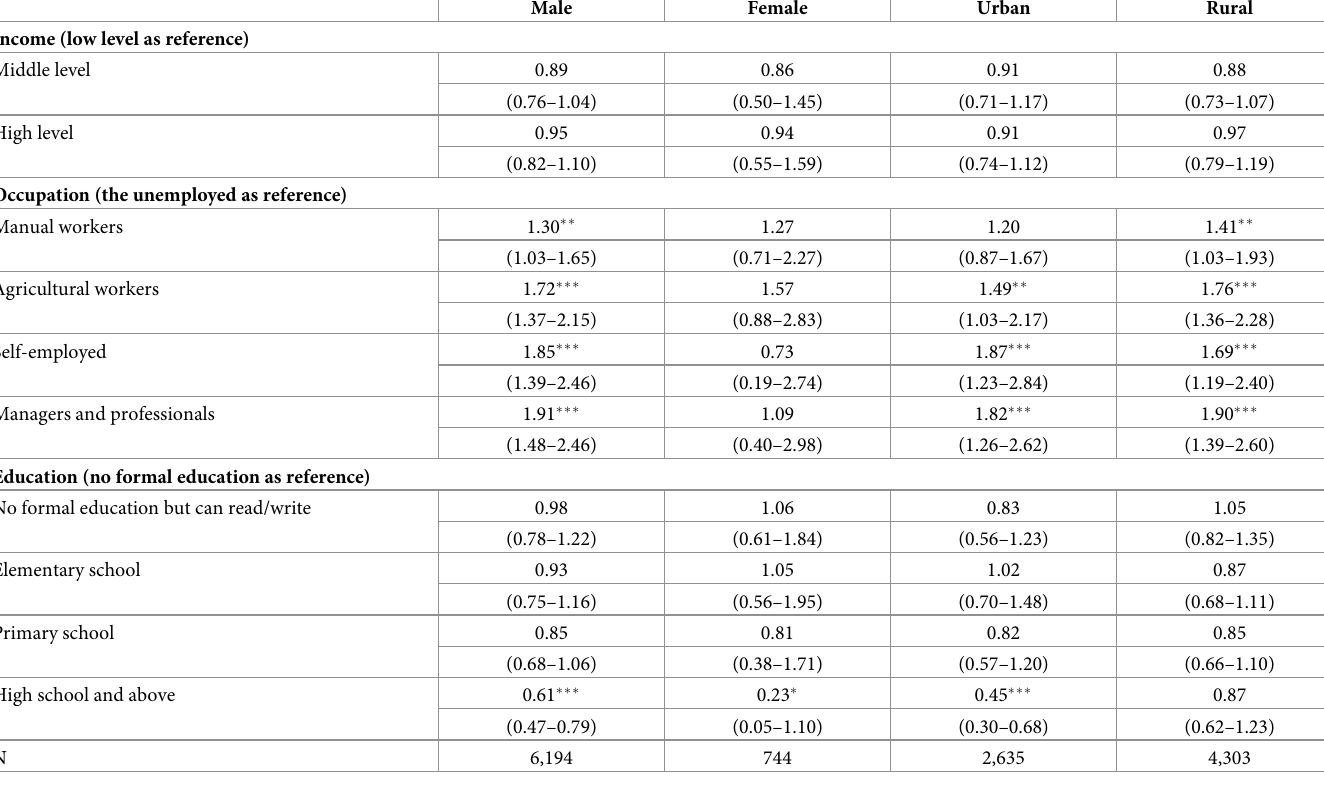
Table 4. Association between SES and high health risk related to smoking using Logit model: OR with 95%